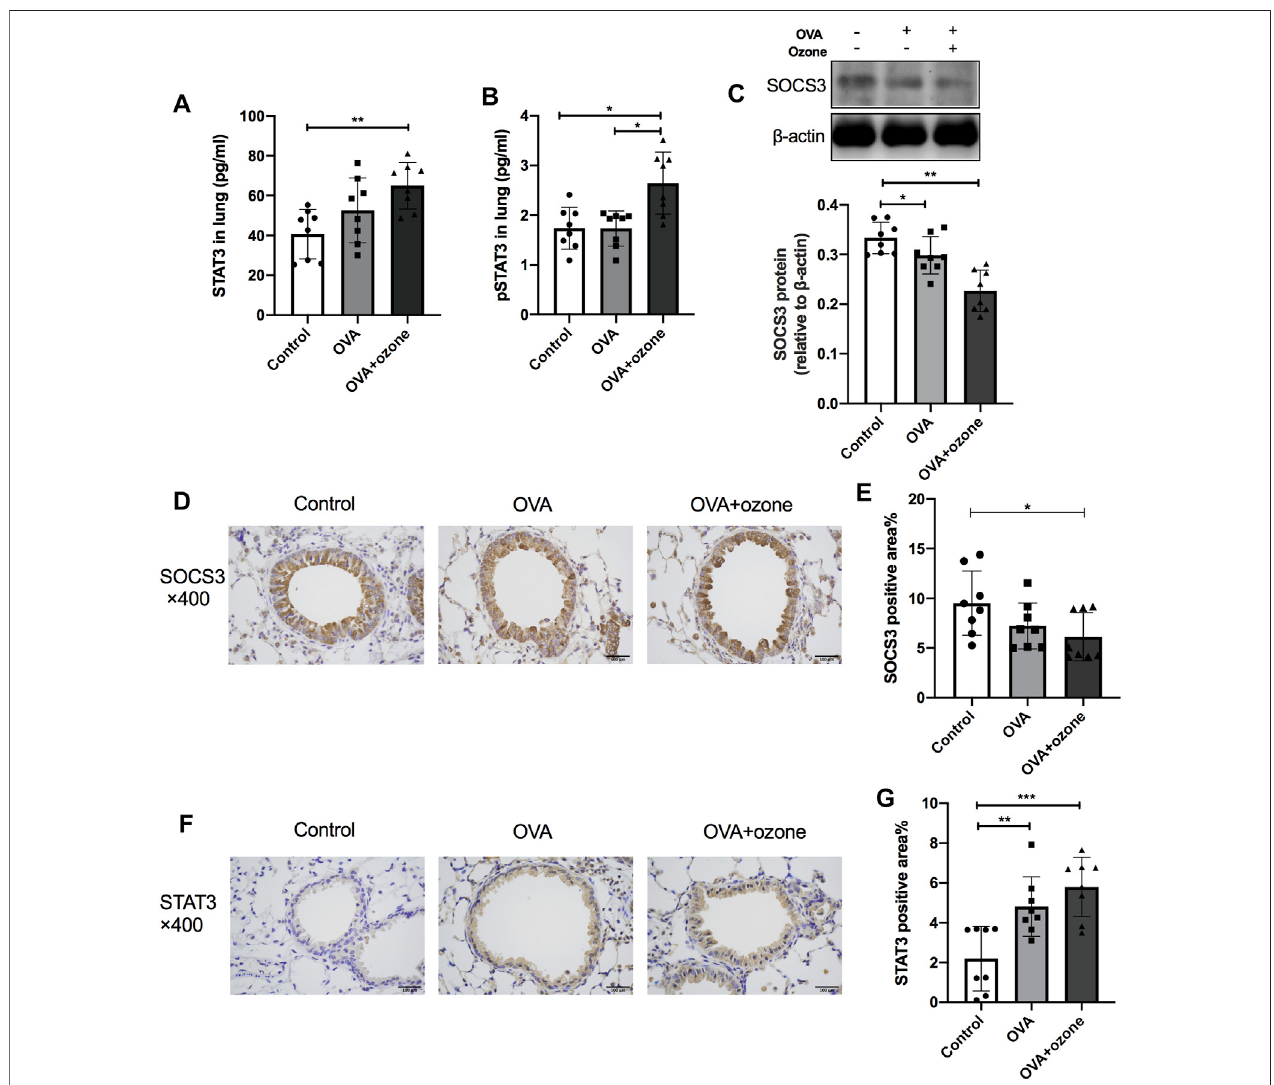
FIGURE4| ExpressionofSTAT3andSOCS3inthelungtissueofmicesufferingfromasthma.TheexpressionofSTAT3andp-STAT3inthelungtissueofmicewas measuredbyELISAs.TheexpressionofSOCS3proteininthelungtissueofmicewasmeasuredbywesternblotting,andproteinexpressionofSTAT3andSOCS3inthe lung tissue of mice was evaluated by immunohistochemistry. (A) Expression of STAT3 protein in lung tissue. (B) Expression of p-STAT3 protein in lung tissue. (C) Expression of SOCS3 protein in lung tissue. (D) Representative photomicrographs of immunohistochemistry of SOCS3 in lung-tissue slices. (E) Percent SOCS3-positive area around airways. (F) Representative photomicrographs of immunohistochemistry of STAT3 in lung-tissue slices. (G) Percent STAT3-positive area around airways. SOCS3, suppressor of cytokine signaling 3; STAT3, signal transducer and activator of transcription 3; p-STAT3, phosphorylated-STAT3. * p < 0.05; ** p < 0.01; *** p < 0.001. Scale bar (cid:1) 100 μ